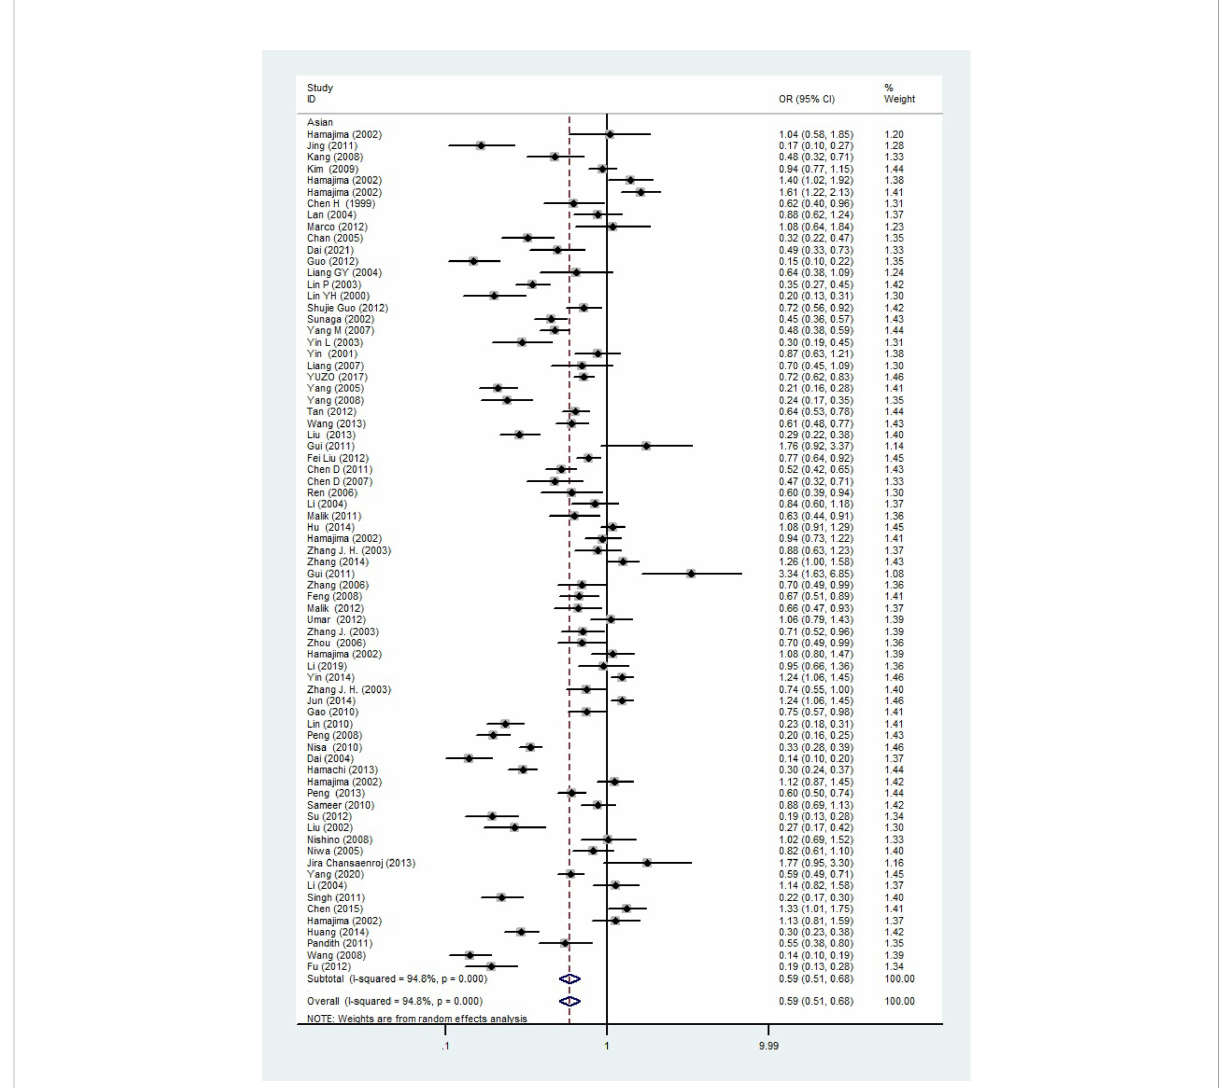
FIGURE 5 The relationship between cancer risk and rs1800566 polymorphism in the NQO1 gene in Asian population (C-allele vs. T-allele model). There were signi fi cantly decreased association between NQO1 polymorphism in Asian population. The squares and horizontal lines correspond to the study-speci fi c OR and 95% CI. The area of the squares re fl ects the weight (inverse of the variance). The diamond represents the summary OR and 95%